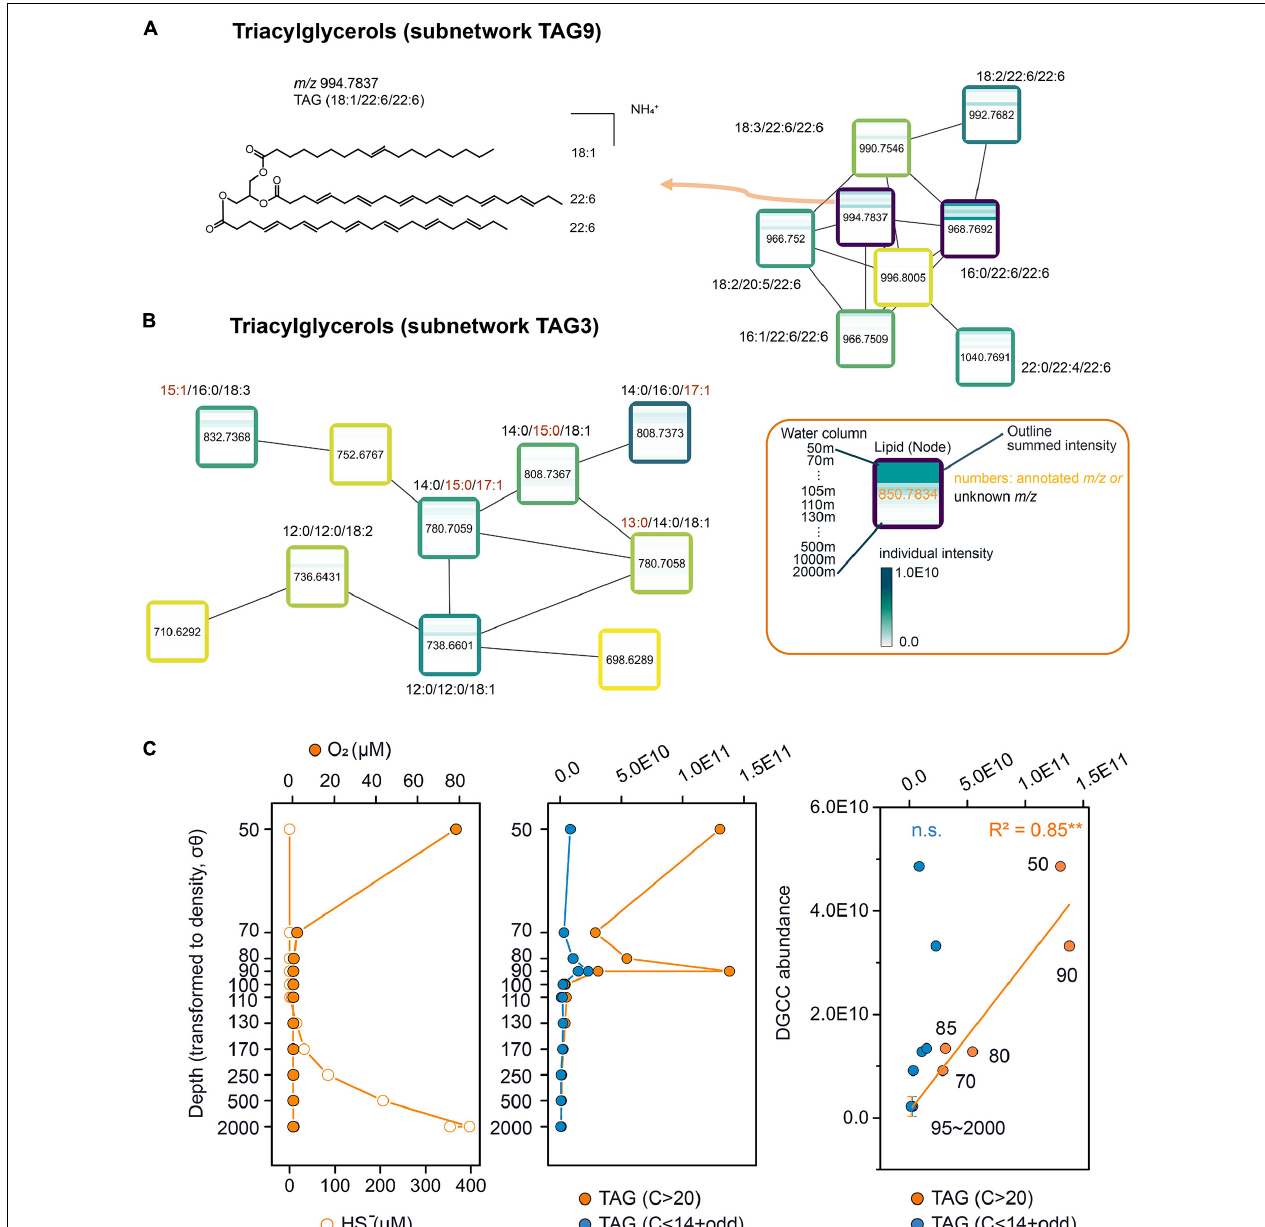
FIGURE 4 | Molecular subnetwork of triacylglycerols and their source determination. (A) Subnetwork of TAG9 . (B) Subnetwork of TAG3. (C) From left to right: Distribution of oxygen (O 2 , µ M, orange solid cycles) and sulfide (HS - , µ M, orange hollow cycles) in the water column of the Black Sea (50–2,000 mbsl); Distribution of summed TAGs with polyunsaturated fatty acids (at least one of the three acyl chain length with more than C 20 , orange cycles) and summed TAGs with odd (C 15 and C 17 ) and short (C 12 and C 14 ) carbon chain length (blue cycles); Scatter plots of DGCC vs. TAGs with polyunsaturated fatty acids (orange cycles) and TAGs with odd (C 15 and C 17 ) and short (C 12 and C 14 ) carbon chain length (blue cycles). Significance: ** P < 0.01; n.s., not significant. The names of these selected lipid classes are linked to the ones in the major network ( Figure 2 ). Boxes shown in subnetwork are the same as nodes shown in Figure 2 , representing lipid species. The outlines of the boxes are labeled from light yellow to dark blue with the increasing of the summed intensity among all the water column samples (15 depths). Inside the box, a heatmap represents the distribution of this lipid species across the water column, from top (50 mbsl) to bottom (2,000 mbsl).